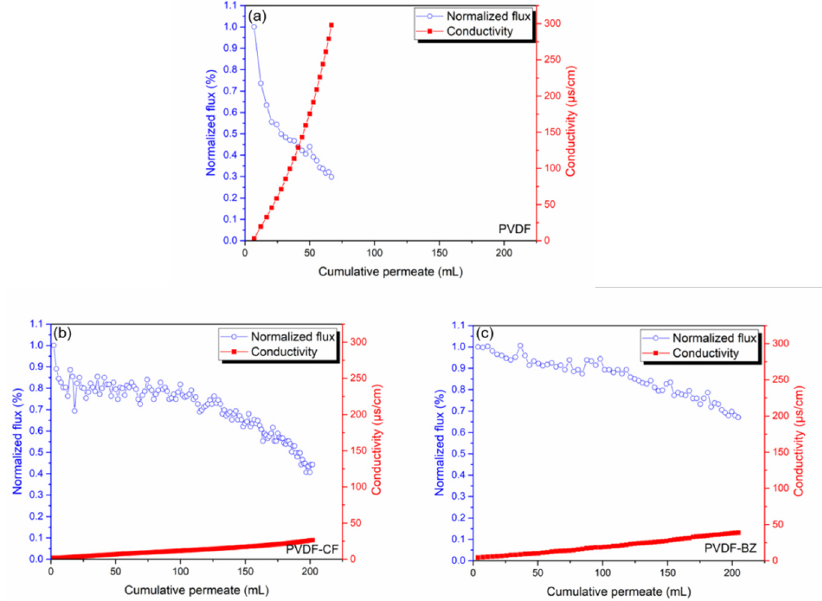
Figure 9. Flux and salt rejection for a produced water (PW) feed stream. ( a ) PVDF membrane, ( b ) PVDF-CF membrane, ( c ) PVDF-BZ membrane. The target water recovery was setup at 40%, or 200 mL permeate. The initial fluxes were ( a ) PVDF membrane: 38.88 Lm − 2 h − 1 , ( b ) PVDF-CF membrane: 16.83 Lm − 2 h − 1 , ( c ) PVDF-BZ membrane: 18.43 Lm − 2 h − 1 .